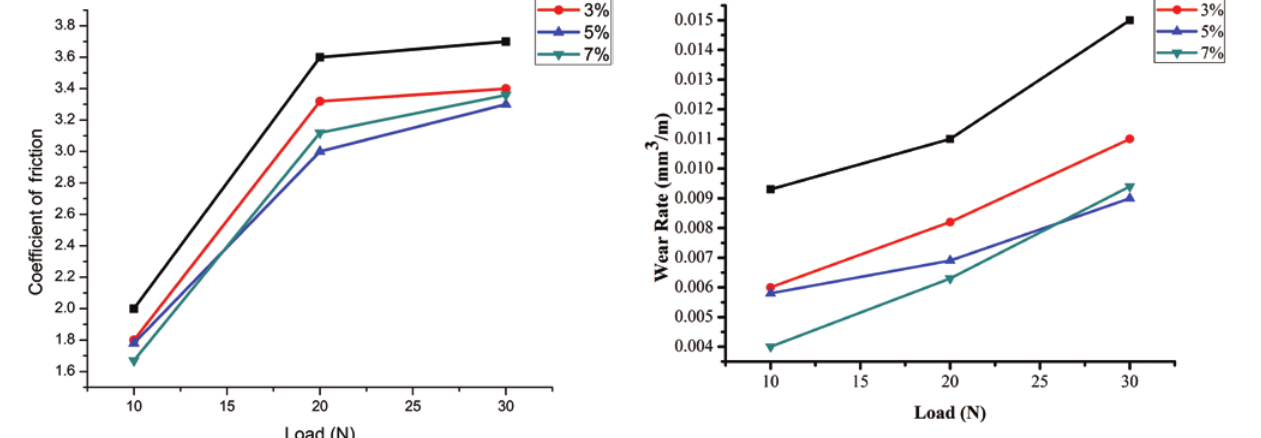
Figure 10: Coefficient of friction as a function of various loads.